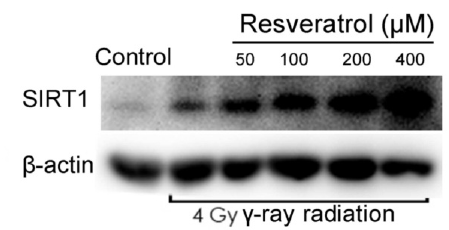
Figure 3. Sirt1 is upregulated in MSCs treated with resveratrol. MSCs were treated with the indicated concentrations of resveratrol, and the relative expression of Sirt1 was determined by Western blot analysis. Values are presented as the mean ± SD ( n = 3). * p < 0.05, ** p < 0.01 compared with